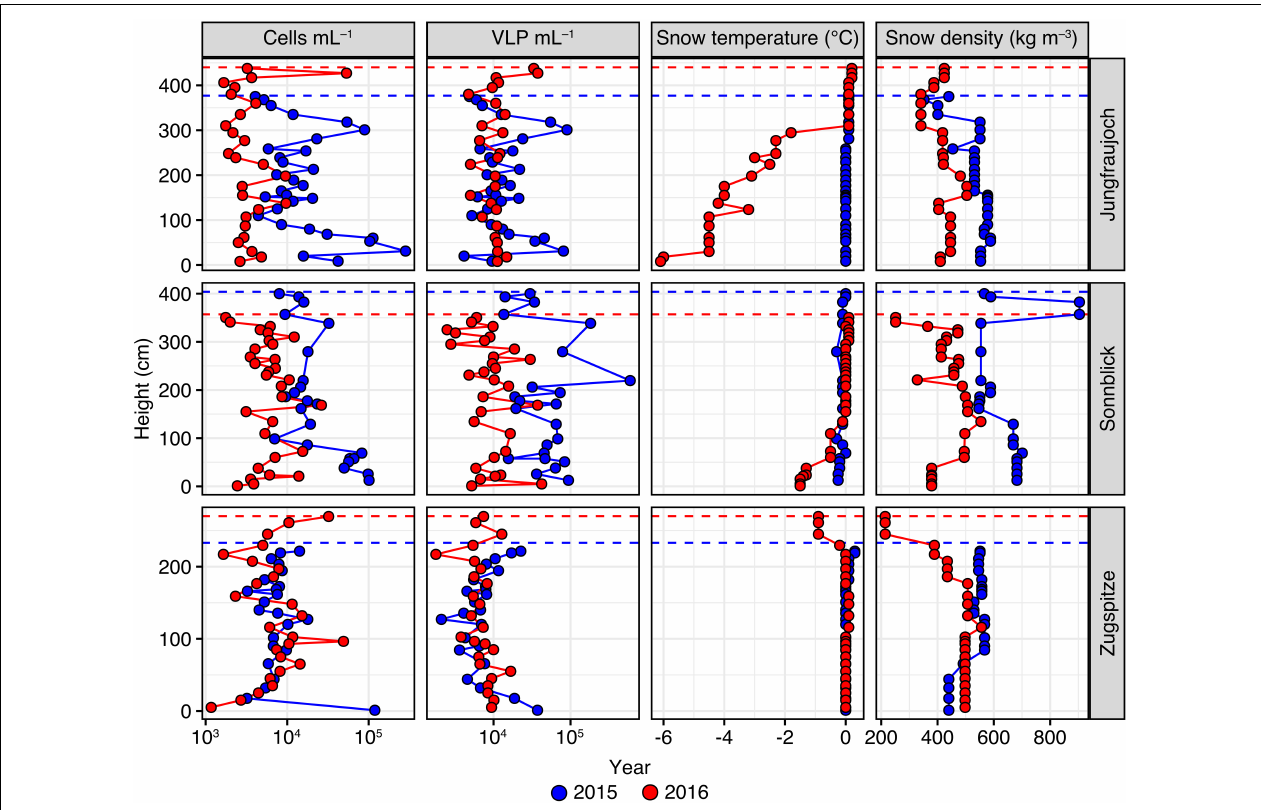
FIGURE 2 | Numbers of prokaryotic cells and VLP per mL snow meltwater, in addition to snow temperature and snow density measured across the snowpack profiles per site and year. Height of the snow layer is given in cm above the bottom of the snowpack. Dashed lines represent the maximum snowpack height for each